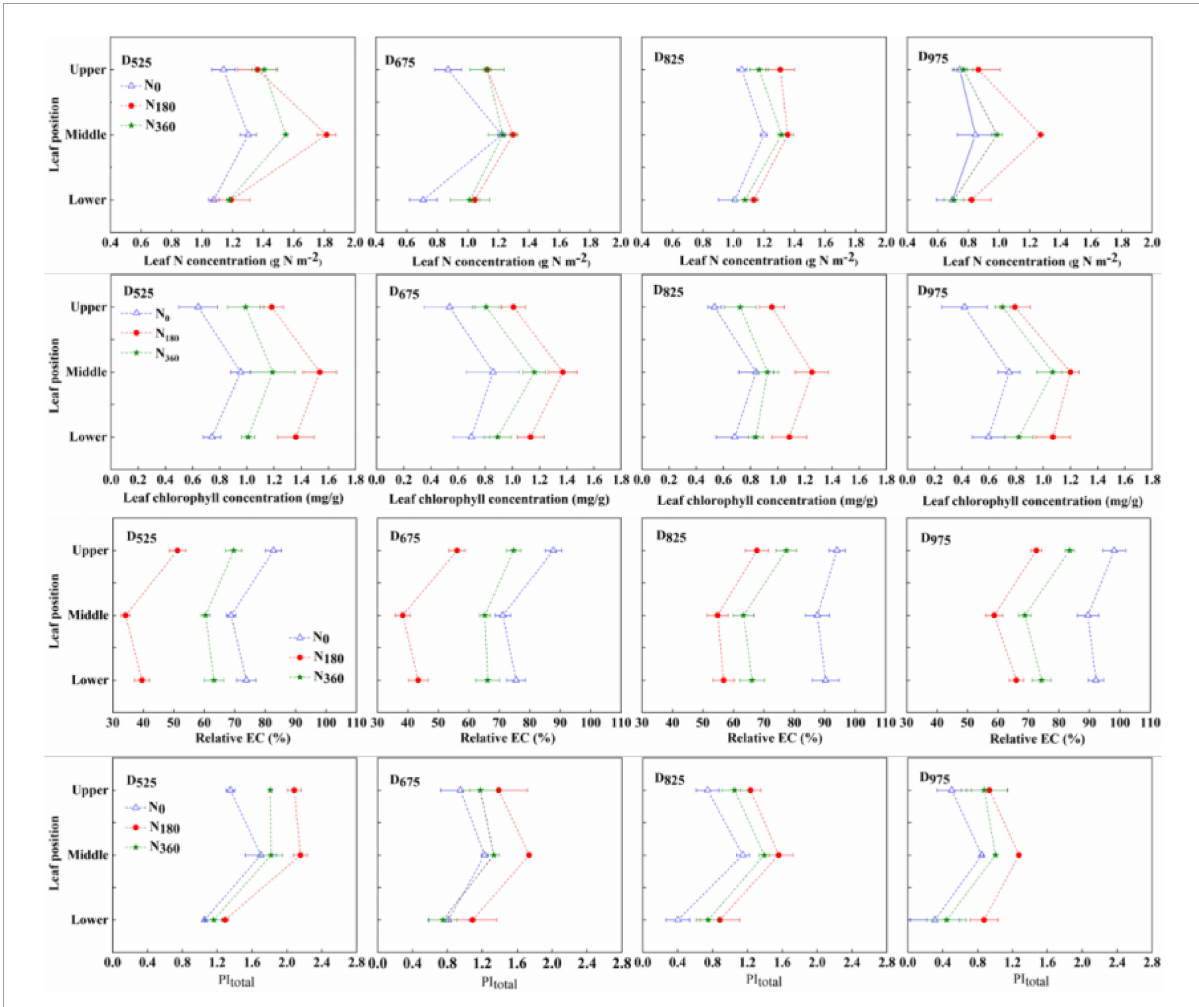
FIGURE6 Influence of N rate and plant density on the leaf N concentration, chlorophyll concentration, relative EC, and PI total at different leaf positions in 2019.